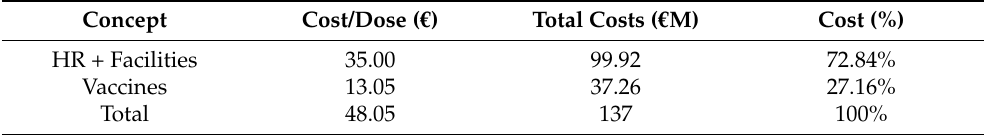
Table 3. Vaccination campaign